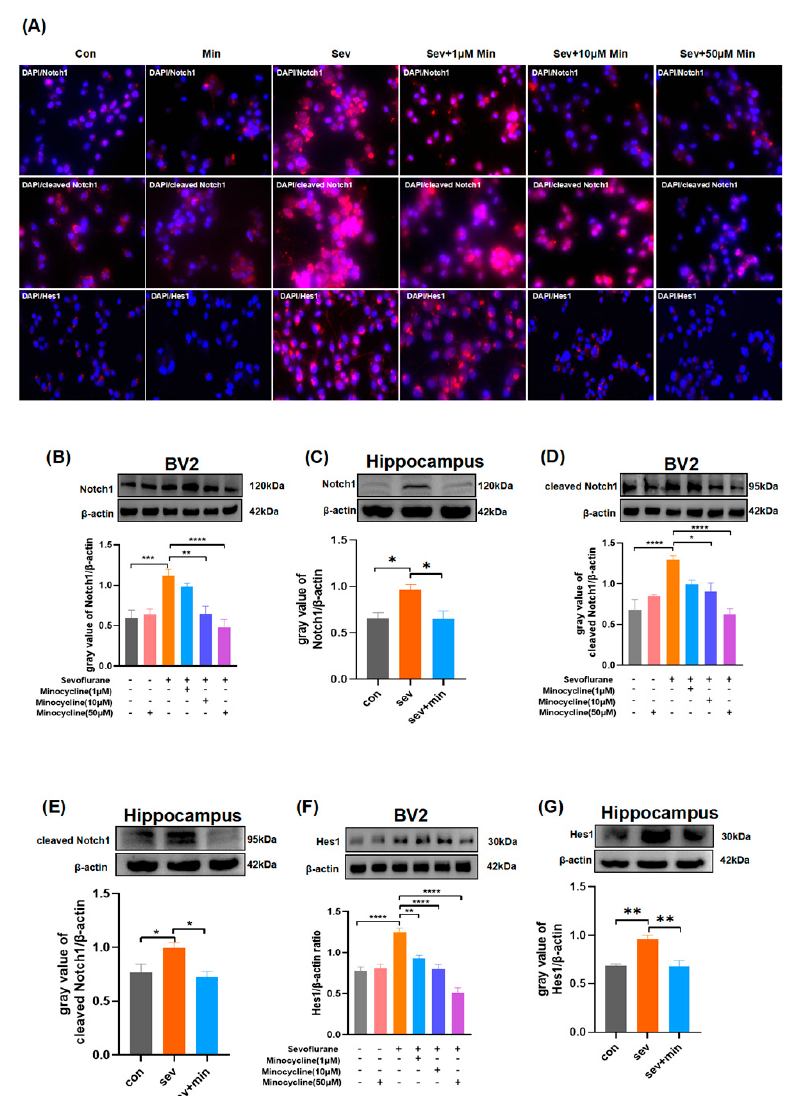
Figure 6. Minocycline alleviates sevoflurane-induced neuroinflammation via Notch signaling sup- pression: ( A ) Cell immunofluorescence was performed to assess Notch signaling-associated proteins in BV2 cells of each group. Scale bar, 20 µ m; ( B – G ) Immunoblot detection of Notch1, cleaved Notch1, and Hes1 in BV2 cells and hippocampal tissue specimens. β -actin was utilized for normalizing data quantitated by densitometry with ImageJ. Data are mean ± SEM. * p < 0.05, ** p < 0.01, *** p < 0.001, **** p < 0.0001.